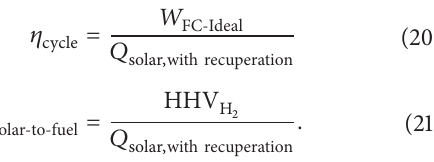
Table 1: Irr 𝑇 𝐻 (K)